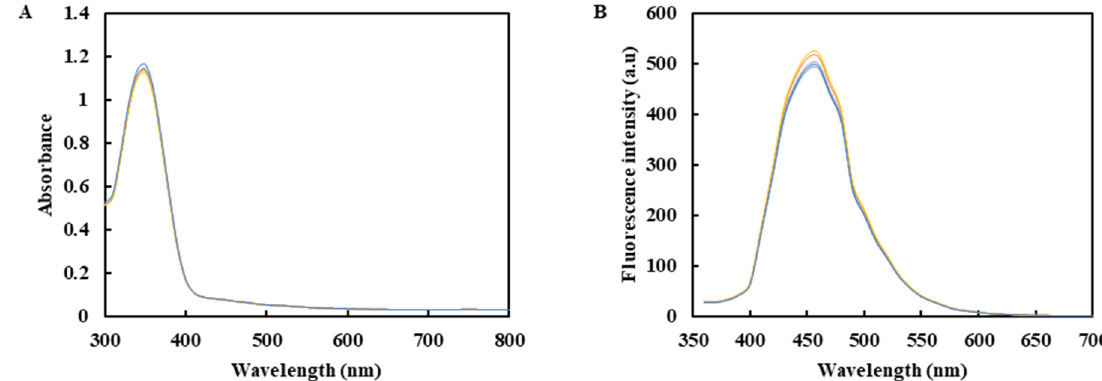
Figure 3. ( A ) Ultraviolet absorption spectrum of CDs. ( B ) The fluorescence emission spectrum of CDs (Excitation wavelength at 360 nm).